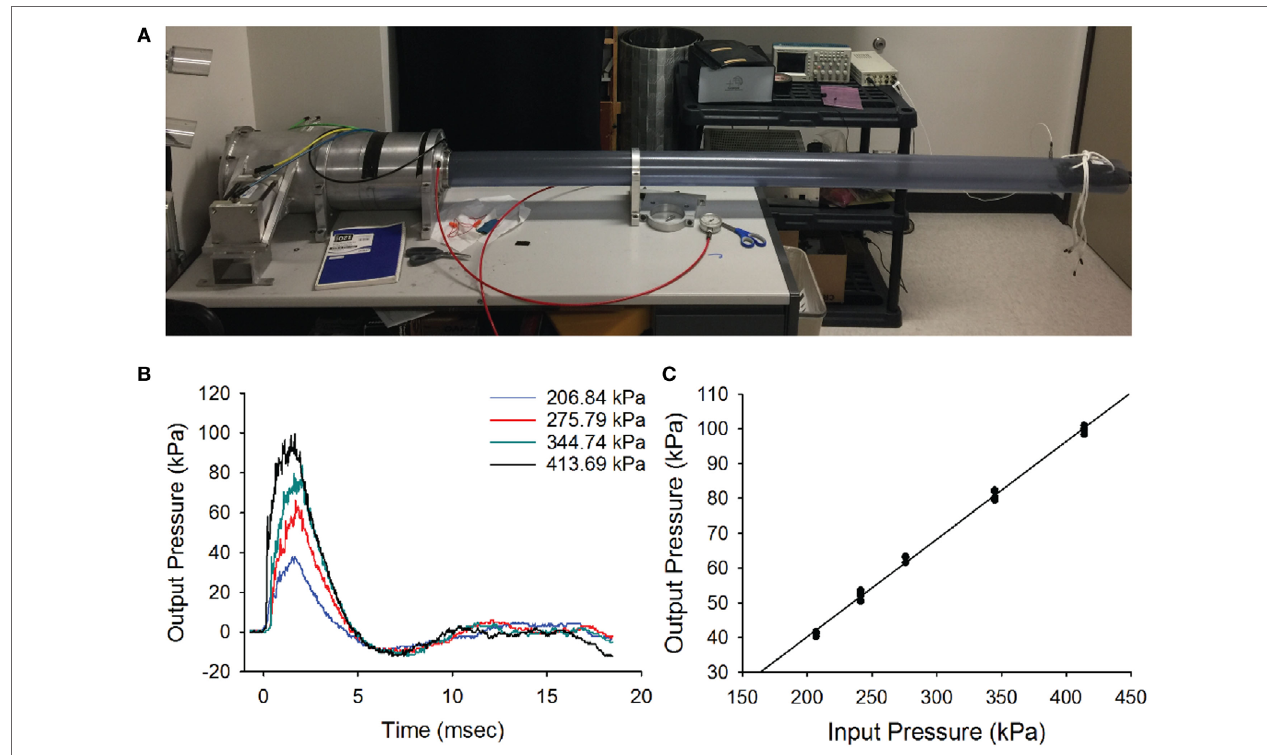
FigUre 1 | Blast wave. (a) The blast-wave device with the mouse holder positioned 8 feet away from the blast chamber. (B) Blast-wave profile measured by a pressure transducer mounted directly under the animal’s head as a function of input pressure (colored traces). A rapid onset of the blast-wave pressure (0 ms) is followed by the blast-wave peak at 2–3 ms. The peak is followed by an under pressure wave at 5–7 ms. (c) Input/output pressure responses follow a proportional relationship. Each point represents one blast repetition. Black line represents fitted